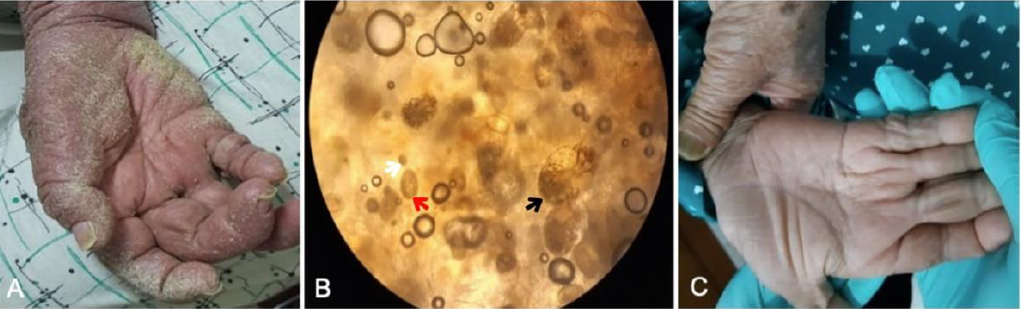
Figure 4. Patient of Case 3 showing gray-yellow crusts on the regio palmar dexter ( A ); Mineral oil scraping showing Sarcoptes scabiei mite (black arrow), eggs (red arrow), and feces (white arrow) at 10-times magnification ( B ) and clinical recovery after two weeks of therapy ( C ).